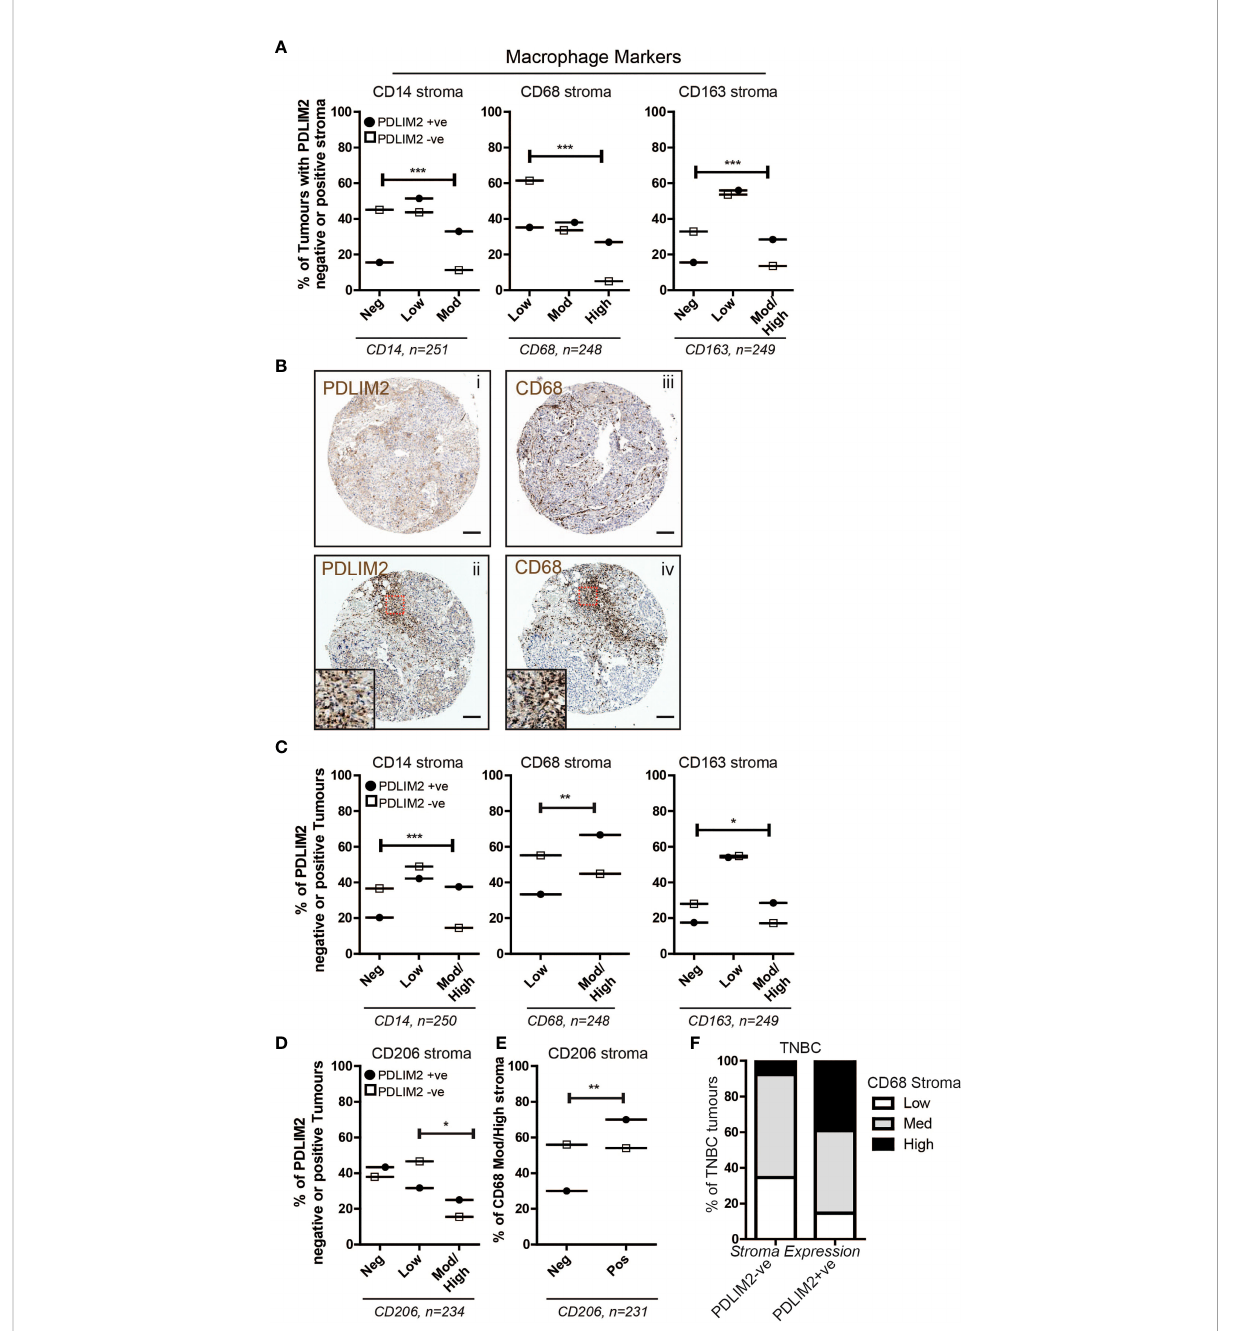
FIGURE 2 PDLIM2 expression is associated with the M2 macrophage population in the breast tumour microenvironment. (A) : Expression of Macrophage markers CD14, CD68 and CD163 in the breast cancer TMA scored as negative, low, moderate or high in PDLIM2-ve or +ve stroma. Data are presented as a percentage of each marker expression score within PDLIM2-ve or +ve groups (from 3 cores). Fisher ’ s exact test: *p<0.05, **P< 0.005, p<0.0001. (B) : Representative micrographs of IHC staining for PDLIM2 (i and ii) and CD68 (iii and iv) in serial sections of TNBC tumours. Insets in panels ii and iv illustrate signi fi cant overlap of high in fi ltration by CD68-positive macrophages in PDLIM2+ve stroma. Scalebars represent 100µm. (C) : Expression of Macrophage markers in the stroma of breast TMA tumours with PDLIM2-ve or +ve tumour cells, as described for stroma analyses in (A, D) : Quanti fi cation of expression of the M2 marker CD206, in PDLIM2-ve or +ve tumours. (E) : CD206 expression in CD68-rich PDLIM2-ve or +ve stroma. (F) : Expression of macrophage marker CD68 in TNBC tumours with PDLIM2+ve or PDLIM2- ve stroma. Representative IHC images capturing negative and positive staining patterns for macrophage markers are shown in Supplemental Figures 1G –